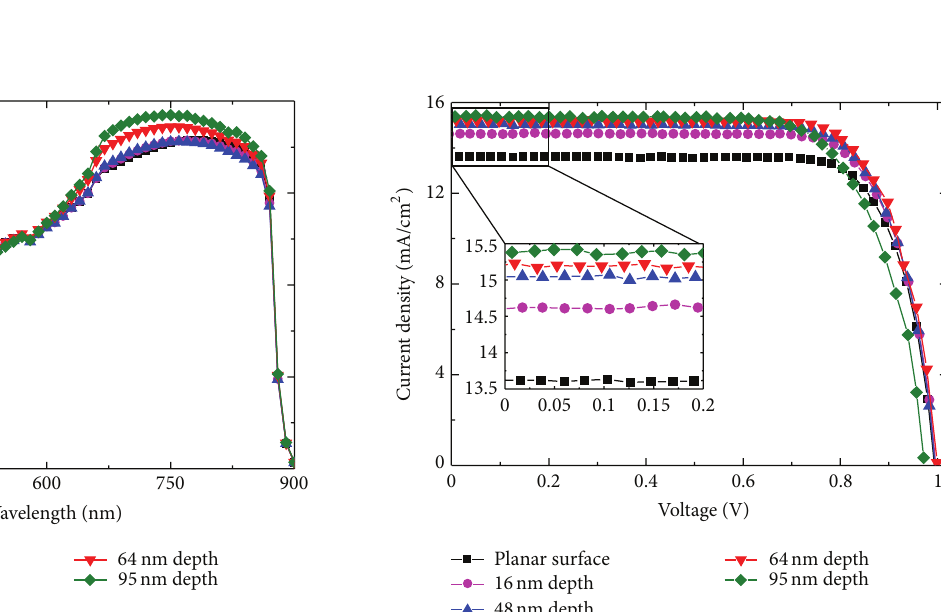
Figure 3: (a) Reflectance spectra at the surfaces of the solar cells with and without nanohole arrays and (b) calculated effective refractive index at 𝜆 = 600 nm near the surface of the solar cells with and without inverted-cone-shaped nanoholes.